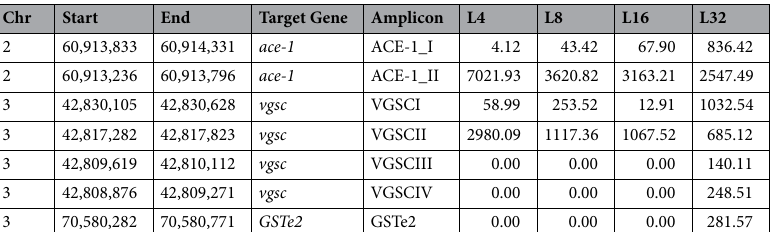
Rate of An. stephensi eDNA degradation in artificial breeding sites.